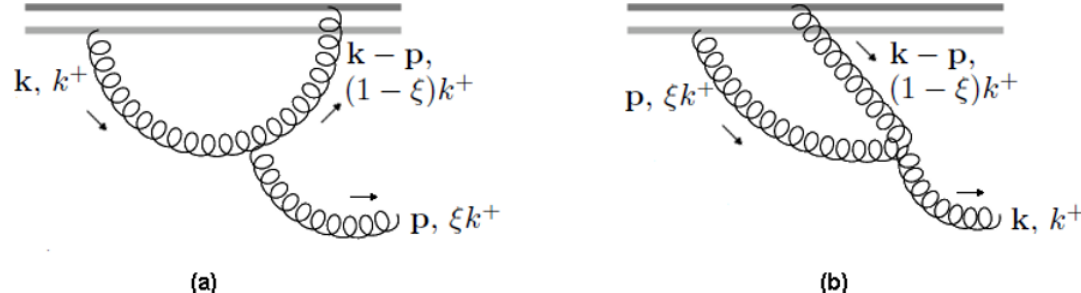
(cid:12) (cid:12) (cid:11) (cid:11) , (b) - . (cid:12) 5 g (cid:12) 6 g